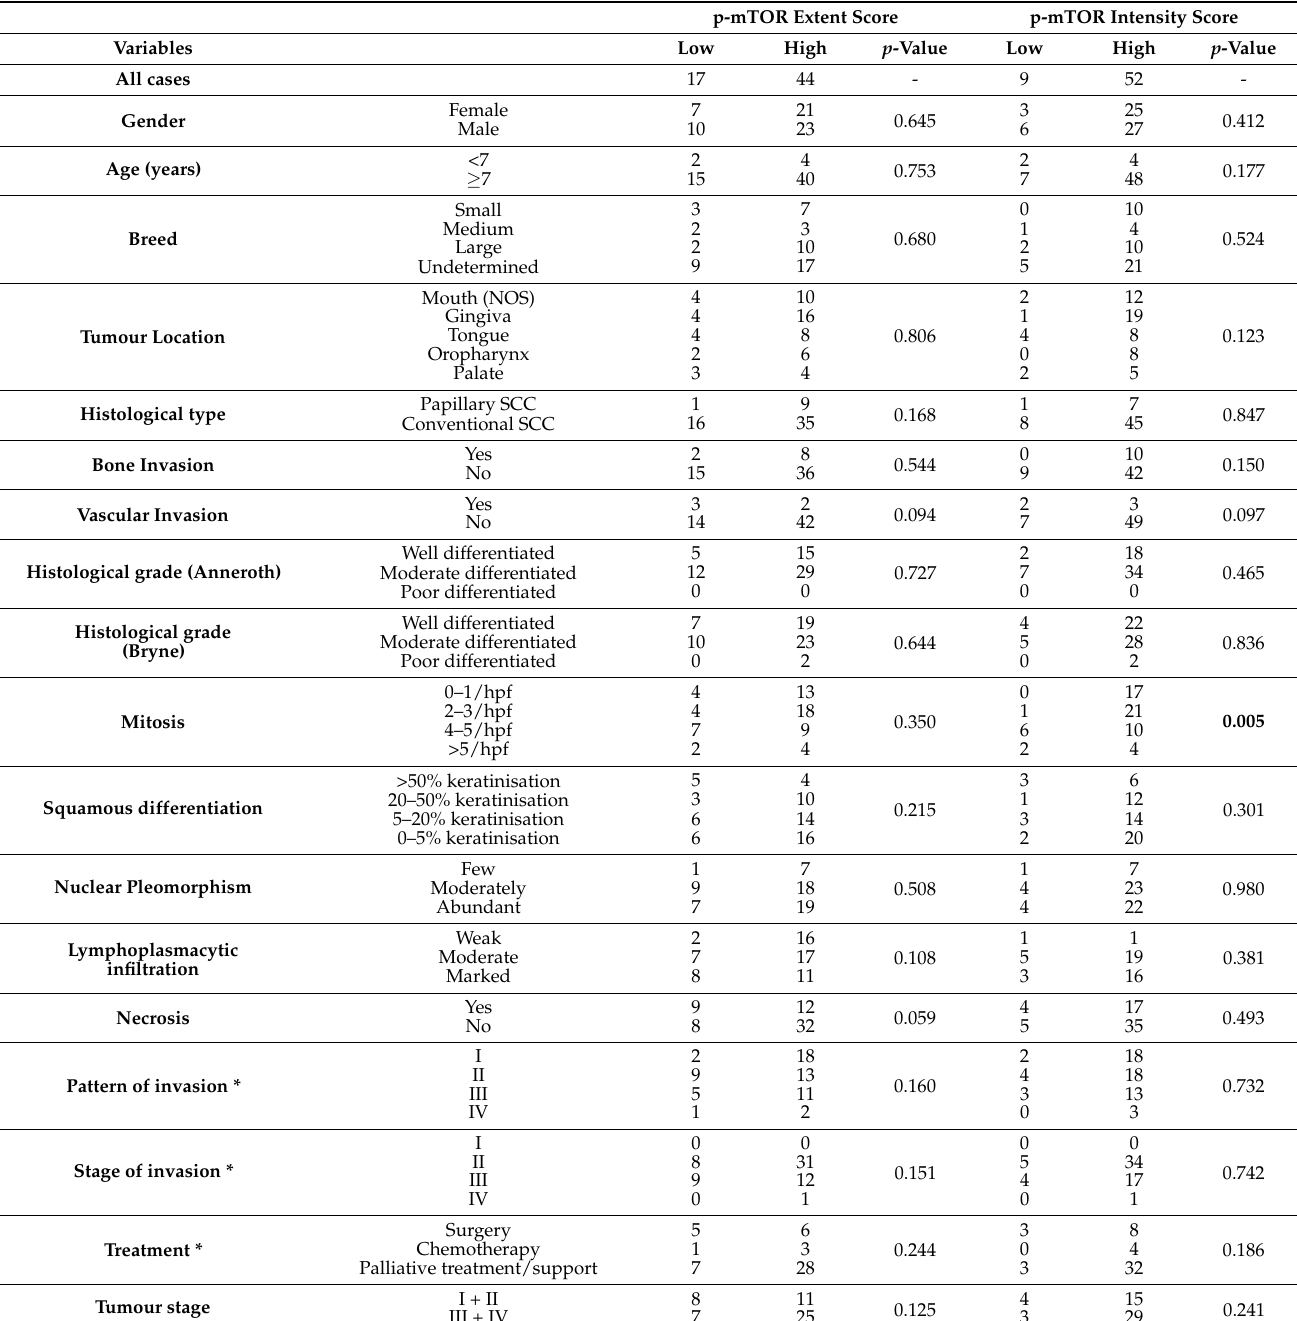
Table 2. Clinicopathological characteristics of the OSCC patients and its association with p-mTOR